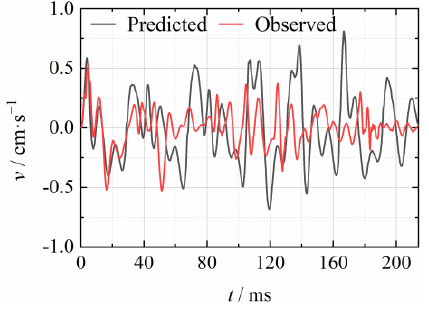
Figure 9. S ( t ) and S ’( t ).